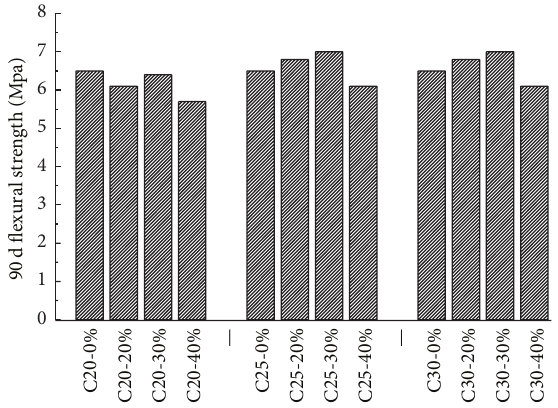
Figure 6: Flexural strength test results.